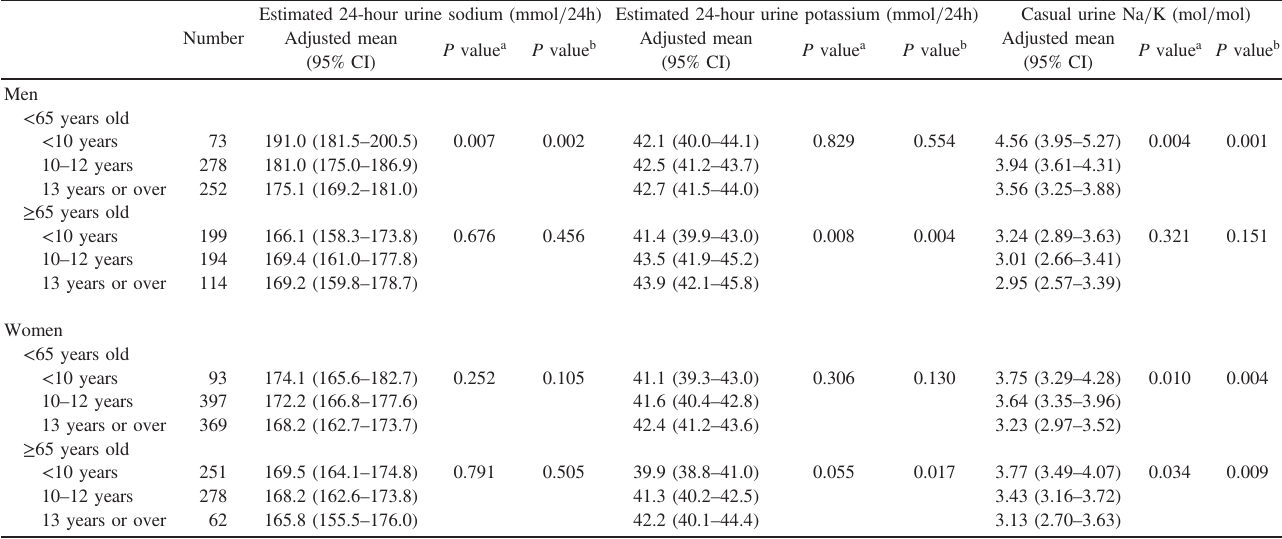
Table 3. Multivariable-adjusted means of estimated 24-hour urine sodium and potassium and casual urine Na / K according to the length of education by sex and age: NIPPON